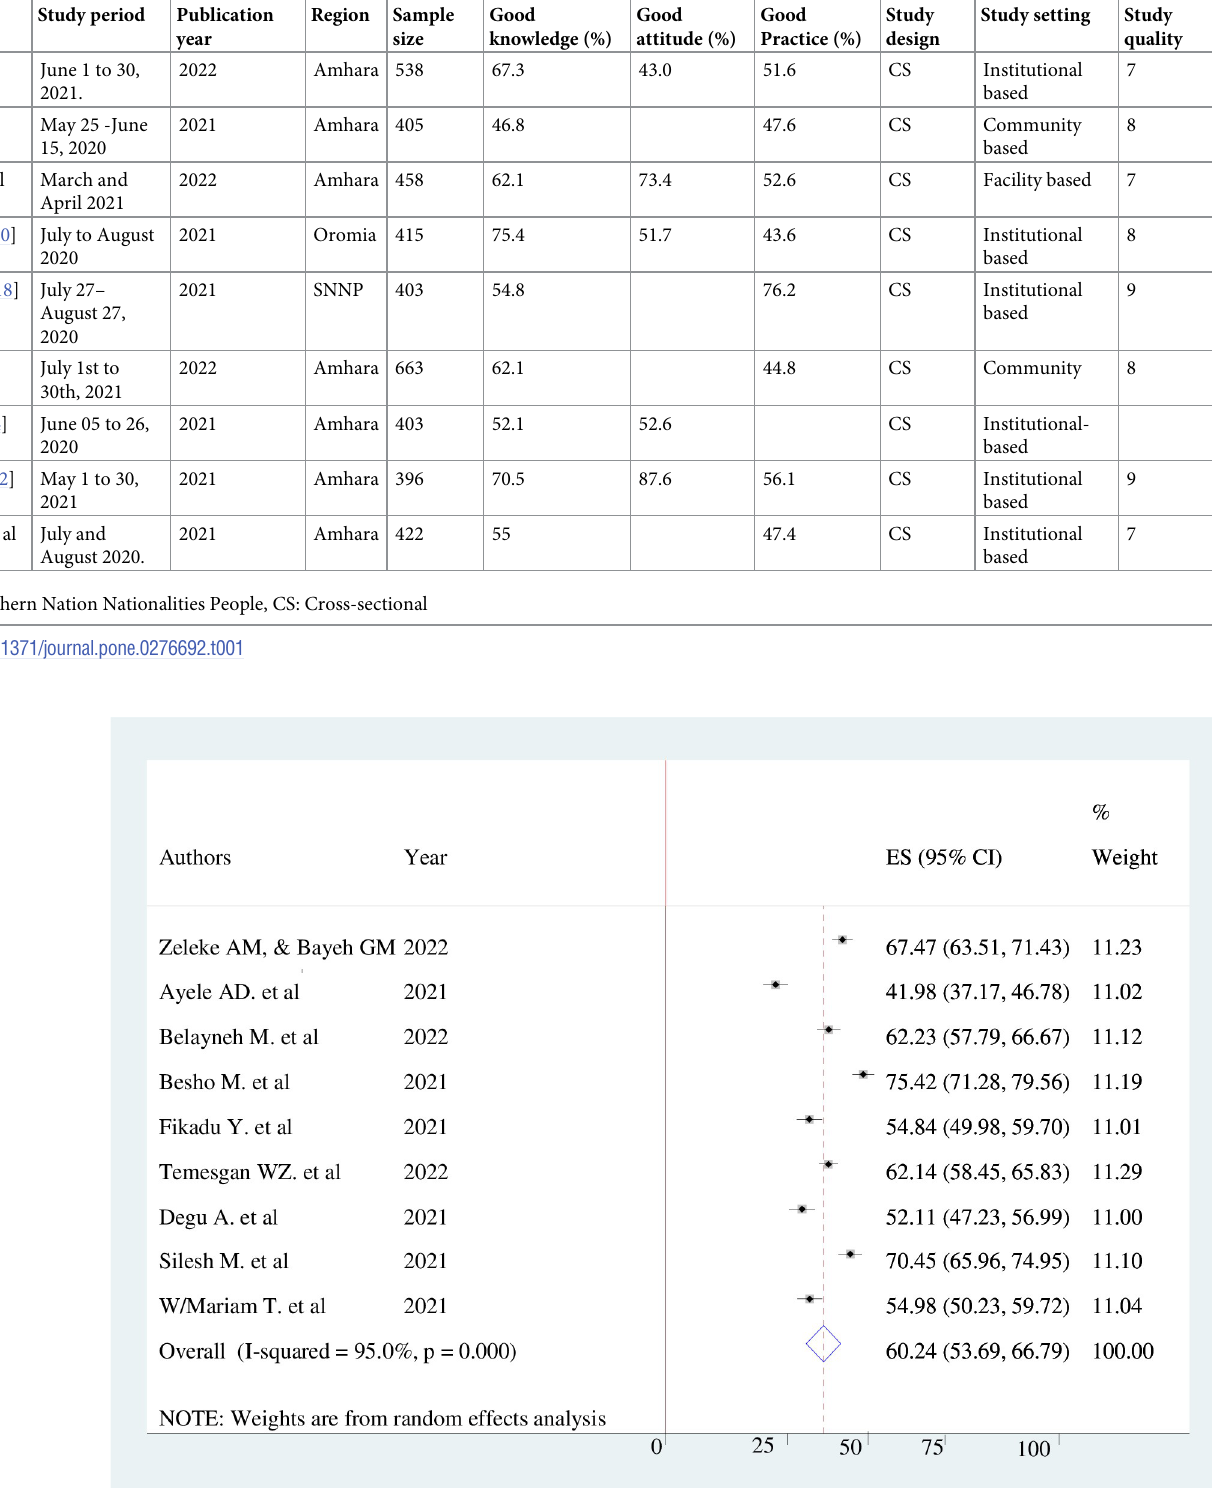
Table 1. Characteristics of included studies in this systematic review and meta-analysis.